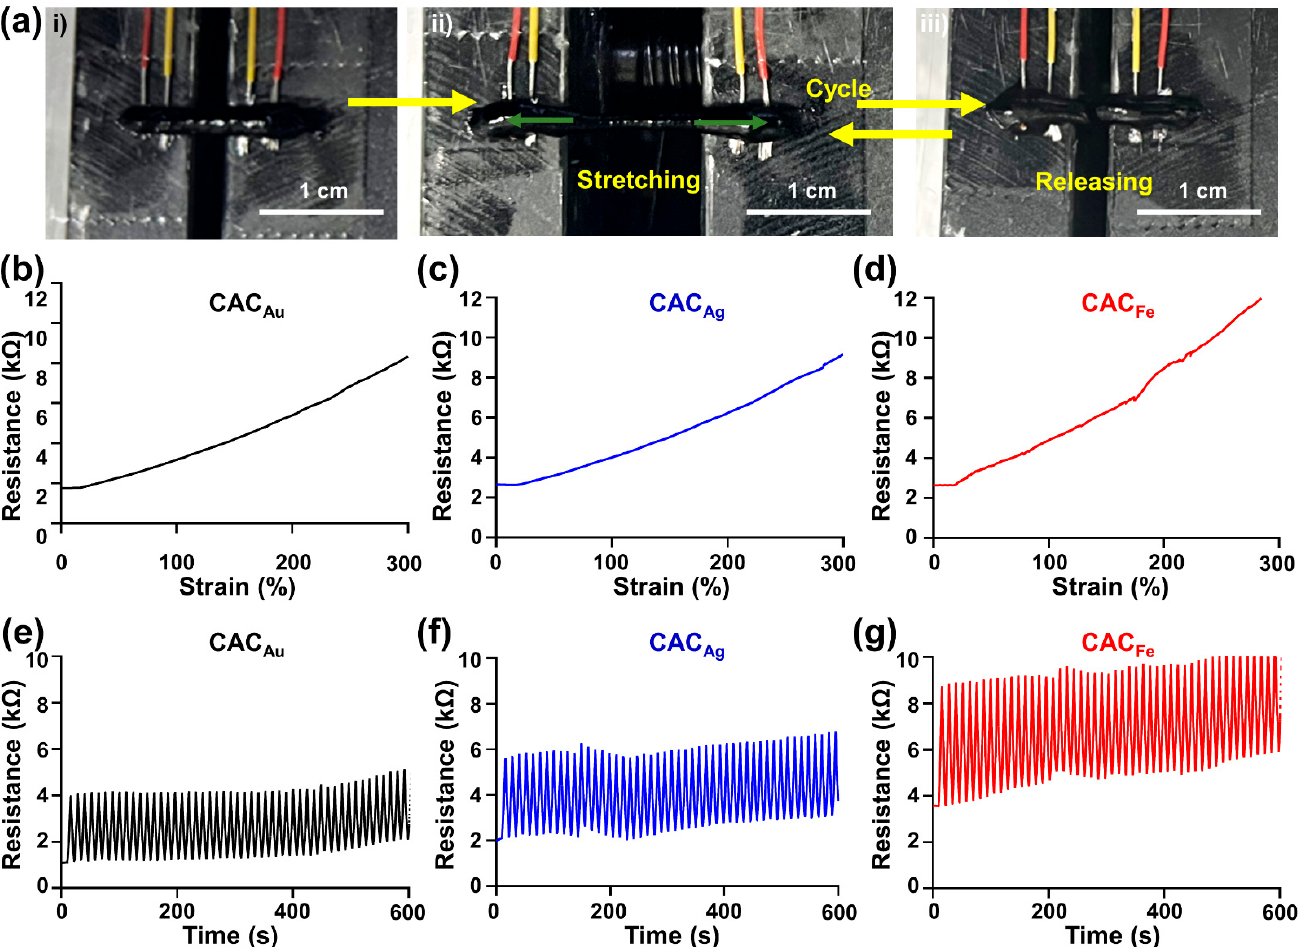
Figure 5. Electrical characterization of CAC hydrogels. ( a ) Macroscopic images: (i) pristine; (ii) stretching; (iii) release. ( b – d ) Continuous tensile strain of the samples at a speed of 3 mm/min: ( b ) CAC Au ; ( c ) CAC Ag ; ( d ) CAC Fe . ( e , f ) Repetitive cyclic stretching test with strains ranging from 0% to 200% at a speed of 1 mm/s for 10 min: ( e ) CAC Au ; ( f ) CAC Ag ; ( g ) CAC Fe .